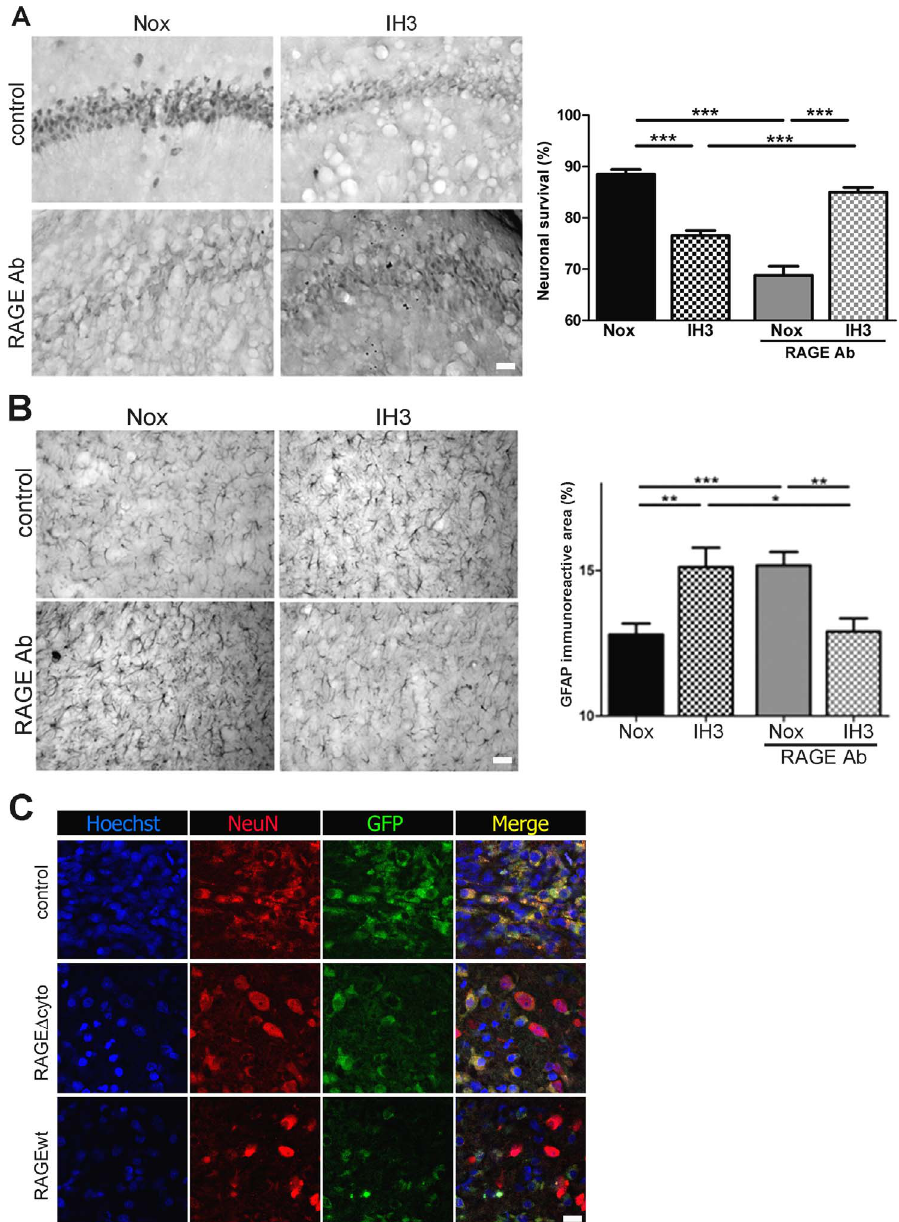
Figure 5. RAGE is required for the neuronal alterations and reactive gliosis induced by IH in vivo . NeuN (A) or GFAP (B) immunostaining in the hippocampal CA-1 region of animals exposed to IH for three days (IH3) and treated with intrahippocampal administrations of RAGE blocking antibodies or control IgG, bar =40 m m. Graphs on the right show the quantitative analysis of the percentage of neuronal survival and of the area covered by GFAP-immunoreactive cells. C: Confocal images of animals that were infected with the HSV-derived amplicon driving the expression of RAGE (RAGEwt), RAGE D cyto or empty sequence and were exposed to IH for three days, bar =15 m m. Data on the graphs are shown as means 6 SEM; significance vs. control group was represented as indicated: * p , 0.05; **p , 0.01; *** p , 0.001 after two way ANOVA and Bonferroni post-test.